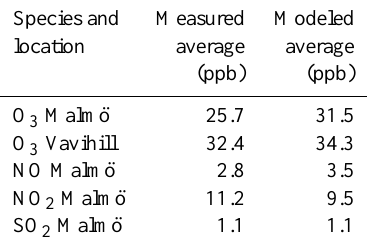
Table 3. Measured and modeled average gas phase concentrations in Malm¨o and at Vavihill for the 26 model cases. Species and Measured Modeled location